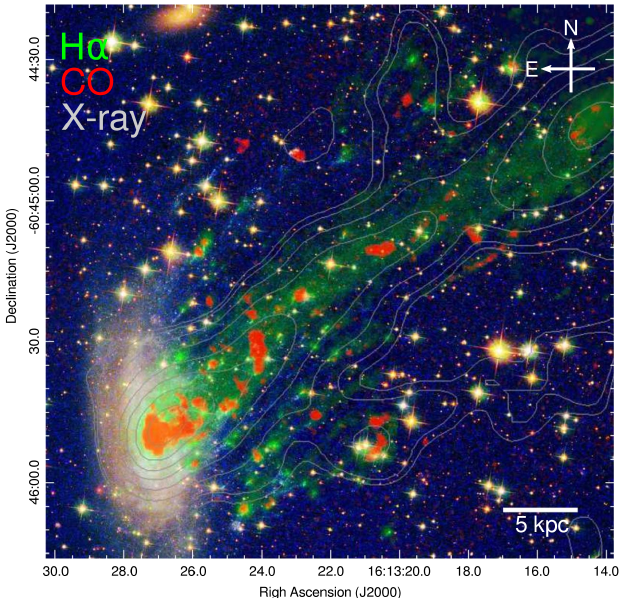
Figure 15. The jellyfish galaxy, ESO 137-001, with ALMA CO (2 − 1) (red), H α from MUSE (green), and Chandra X-ray emission (contours), overlaid on a 3-color image from HST . At 350kpc resolution, the CO is distributed along filaments and clumps, potentially representing different phases of gas stripping. Figure adapted from Figure 3 in Jáchym et al. [731], reproduced by permission of the